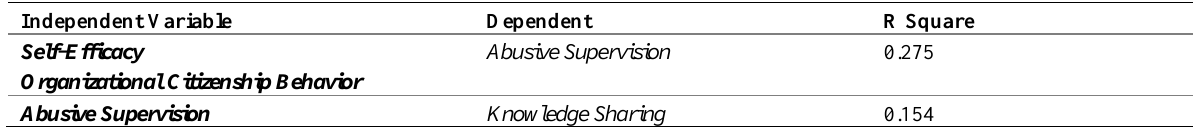
Table 5: R-Square Test Results